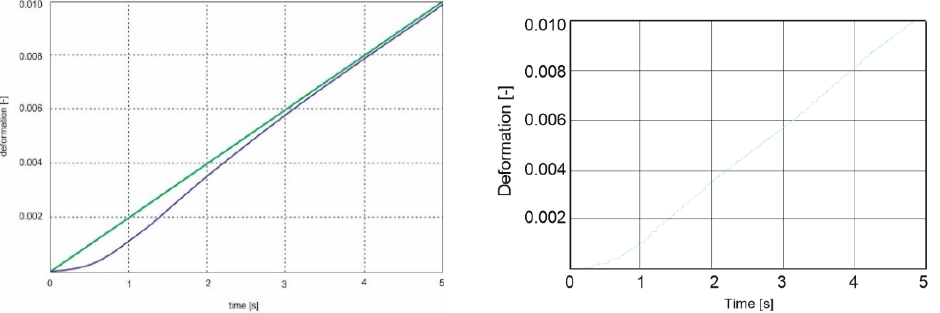
Figure 36. On left side—comparison of the setpoint (green line) and the controlled variable (blue line). On right side—real output of the extensometer.